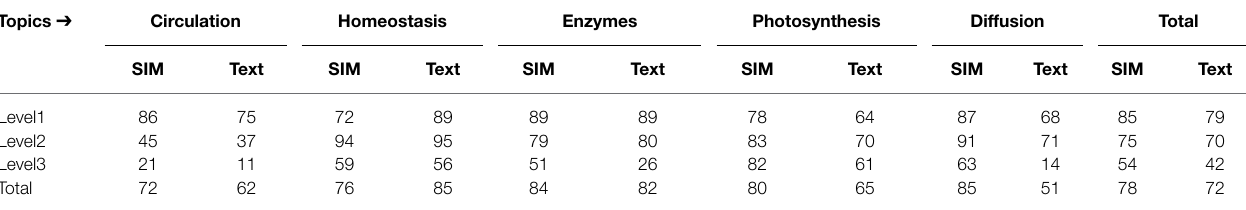
TABLE 10 | Comparing 8th grade biology classes using SIM-based generative practices vs text-based illustration practices.